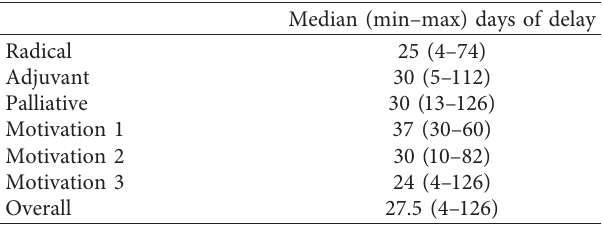
Table 5: Mean time of delay in patients with the postponed procedure according to the intent of treatment and